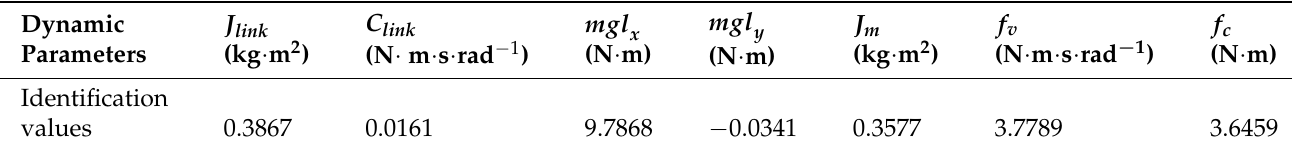
Table 4. The results is the dynamic parameters